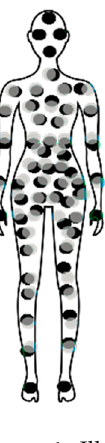
Figure 1. Illustrative image of pain mapping in women with endometriosis (grey dots, adapted from [12]) and CPBPS (black dots, adapted from [11]), regardless of the reported intensity of the pain.